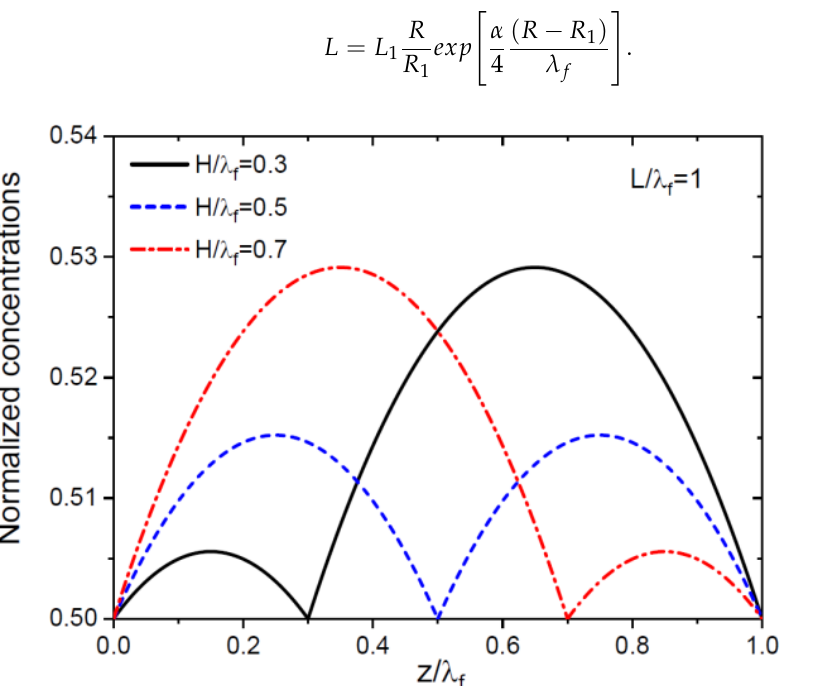
Figure 3. Dimensionless adatom concentrations on the NW sidewalls versus the normalized height along the NW axis for different H / λ f shown in the legend and obtained from Equation (41) at L / λ f = 1.